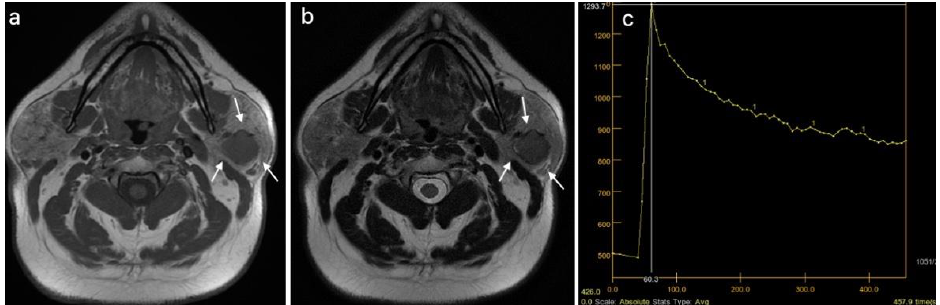
Figure 4. Warthin tumor of the left parotid gland (white arrows): ( a ) T1WI sequence showing a hypointense signal in the tumor, well delineated, with slightly irregular borders; ( b ) T2WI sequence showing a predominantly hypointense signal in the lesion, with peripheral cystic area; ( c ) DCE-MRI showing a type B TIC curve.